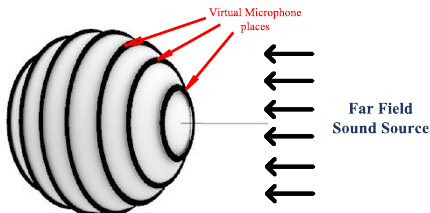
Fig. 3 Proposed microphone array geometry is the parallel rings with equal